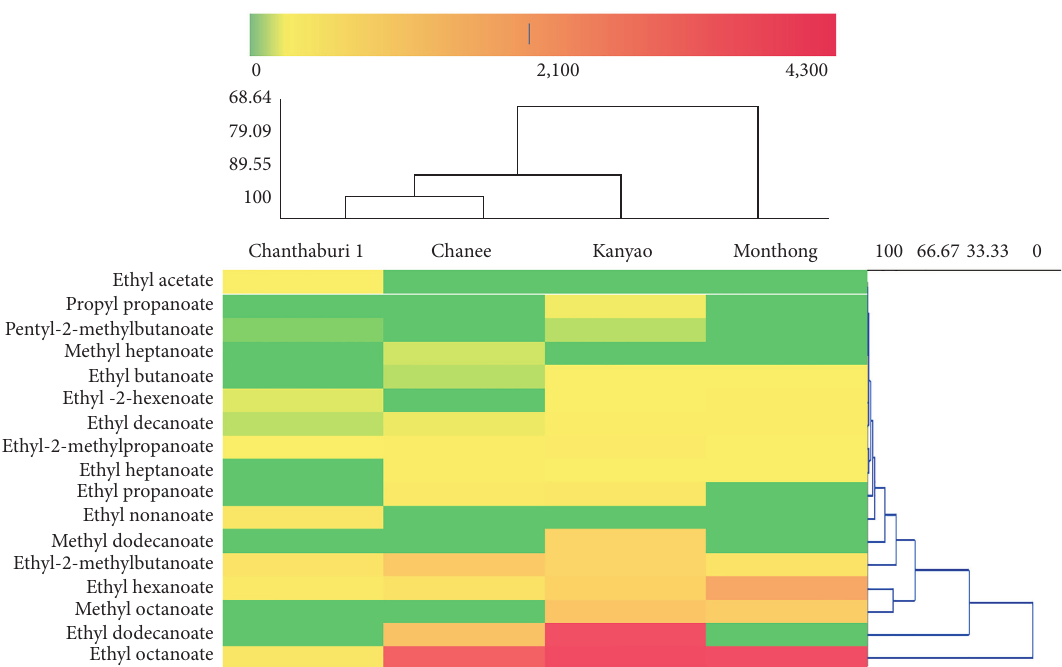
Figure 4: Heat map of odor activity value (OAV), which is greater than 1 of each durian